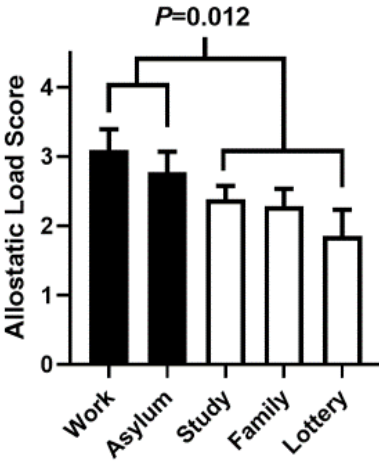
Figure 1. Allostatic Load Score by Reason of Immigration. Data presented as mean ± SE. P -value for downward trend across the 5 reasons of immigration is: 0.004. Mean ALS for [Work + Asylum / Refugee] vs. [Study + Family Reunification + Lottery] is: 2.93 + 1.64 vs. 2.30 + 1.63, p = 0.012.